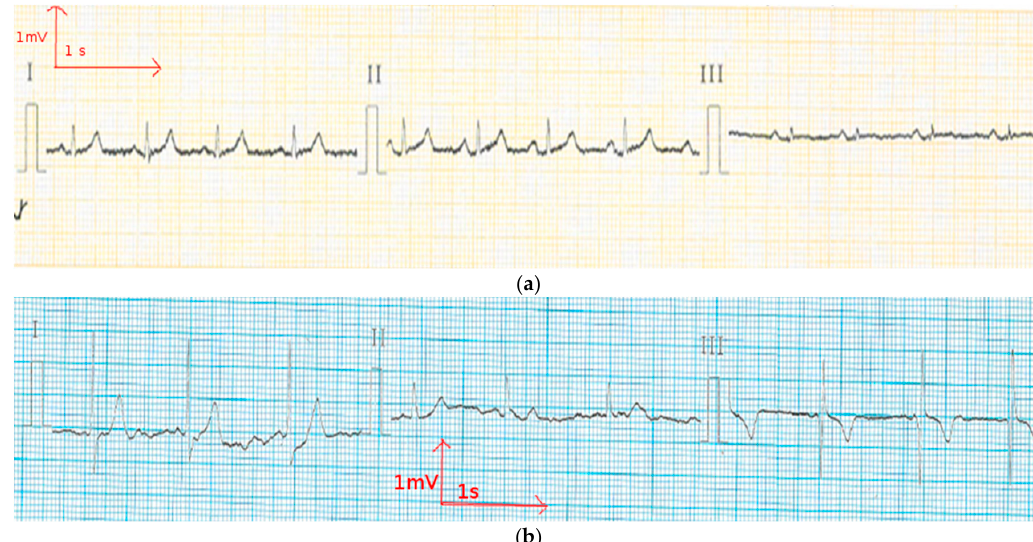
Figure 6. Electrocardiography at rest from the polyamide electrode ( a ) before washing, and ( b ) after 50 washing cycles.